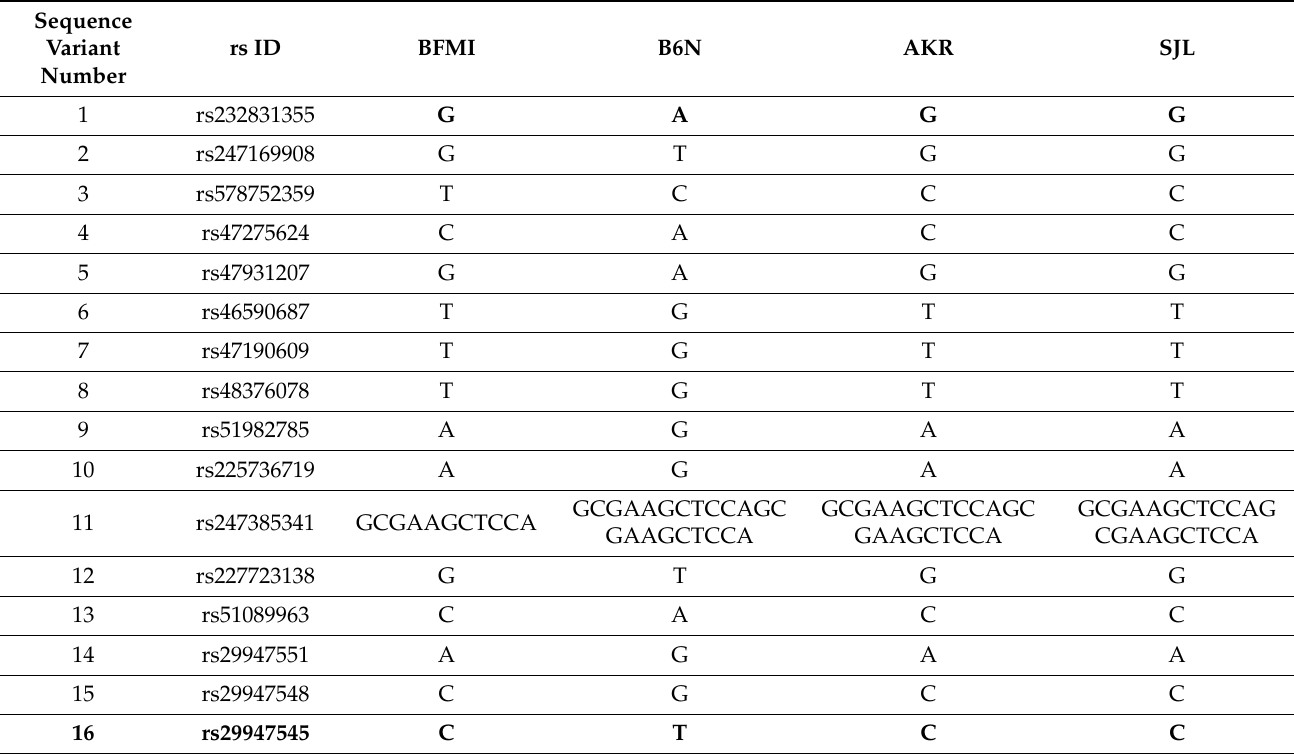
Table 1. Sequence variants in the selected 949 bp promoter region including the 159 bp 5 (cid:48) UTR in BFMI, B6N, AKR, and SJL. The causal SNP rs29947545 responsible for the reduction in expression in the dual-luciferase assay is shown in